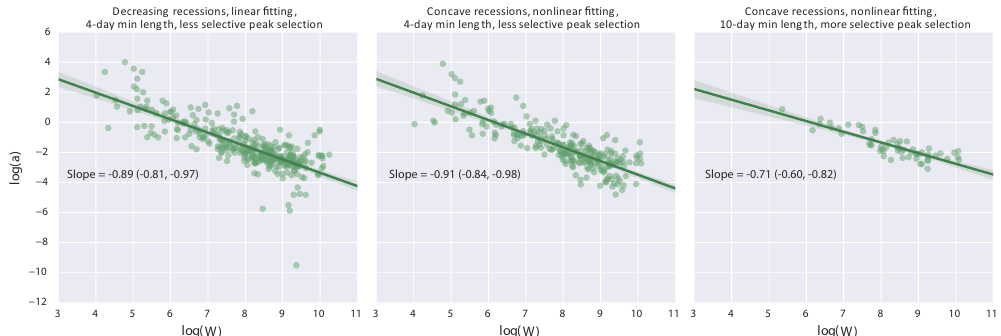
Figure 11. The recession scale parameter plotted against antecedent catchment wetness for three method combinations, together with a linear fit for each point cloud, and a 95% confidence interval for each fitted